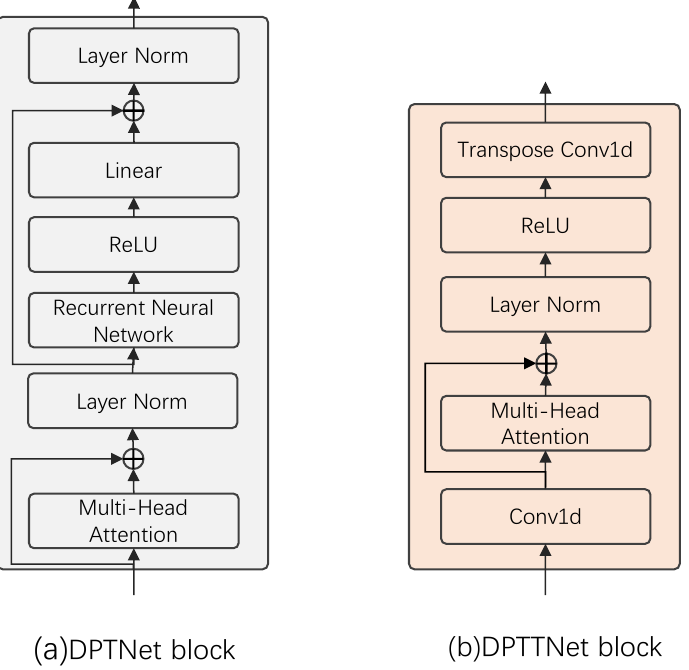
Figure 7. DPTNet block and DPTTNet